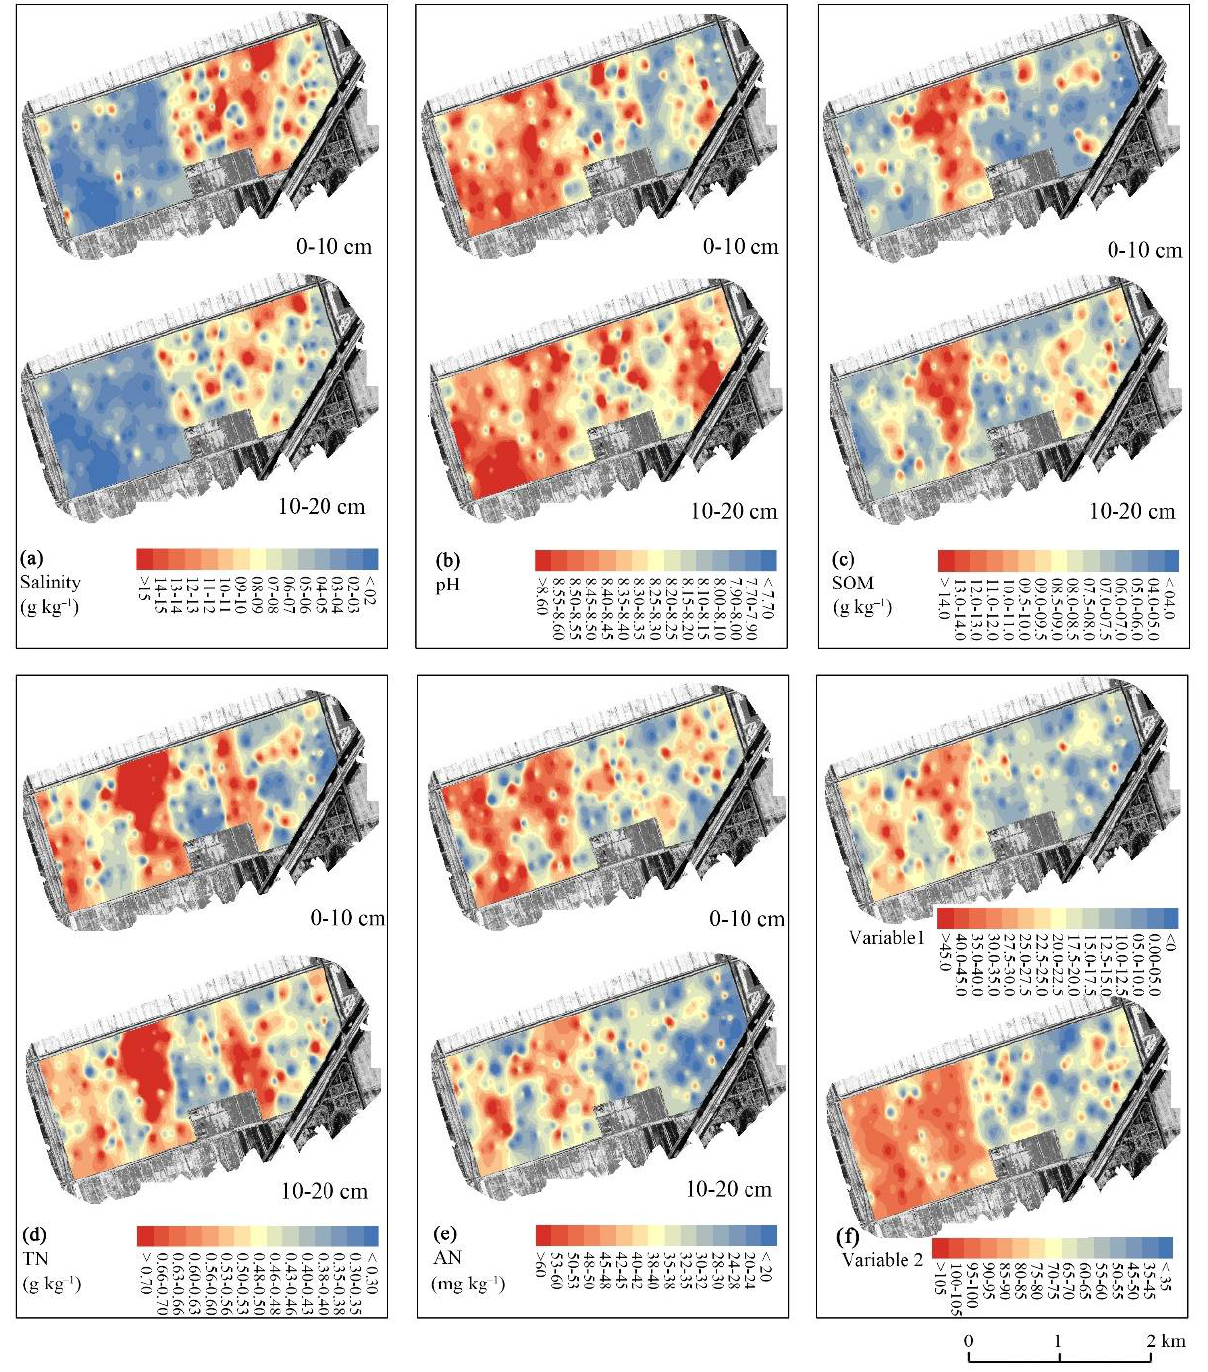
Figure 4. Spatial variations of soil: ( a ) salinity content (g kg − 1 ); ( b ) pH values (unitless); ( c ) organic matter (SOC, g kg − 1 ); ( d ) total nitrogen content (TN, g kg − 1 ); and ( e ) available nitrogen content (AN, mg kg − 1 ) at 0–10 cm and 10–20 cm layers within the experimental site; and ( f ) Variables 1 and 2 (unitless, see Section 2.4.2).